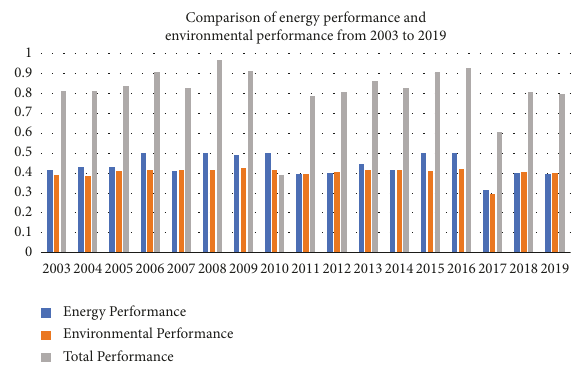
Figure 2: Comparison of energy performance and environmental performance from 2003 to